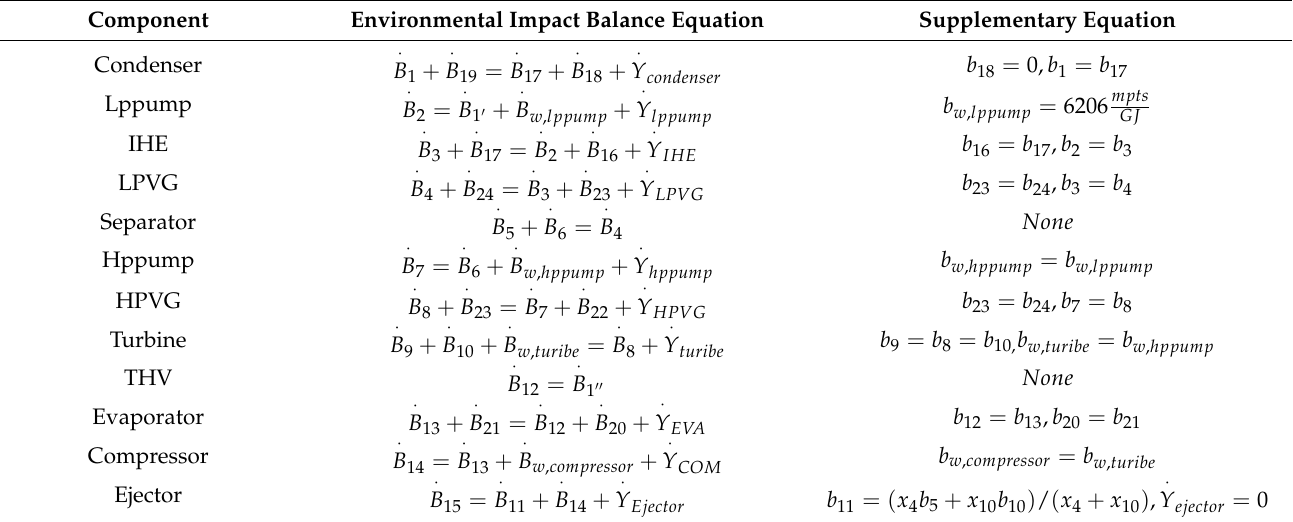
Table 5. Exergy environmental impact balance equation and supplementary equation of each